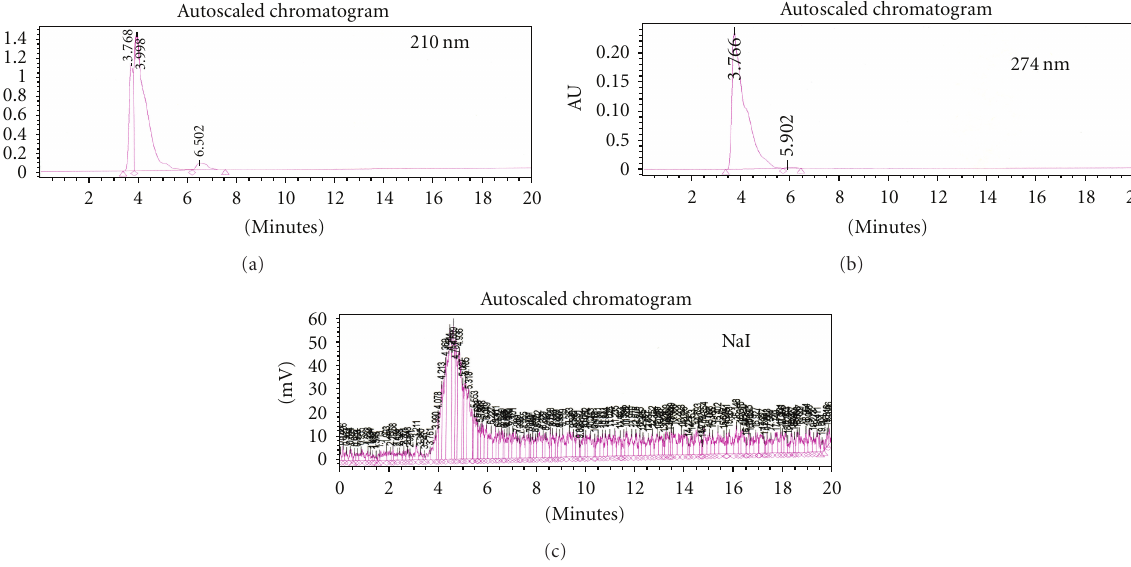
Figure 2: High-performance liquid chromatographic analysis of 99m Tc-N4-Tyrosine at a flow rate of 0.5 mL/minute using a C-18 reverse column under ultraviolet absorbance of 210 nm (a) and 274 nm (b), as well as under a NaI radioactivity detector